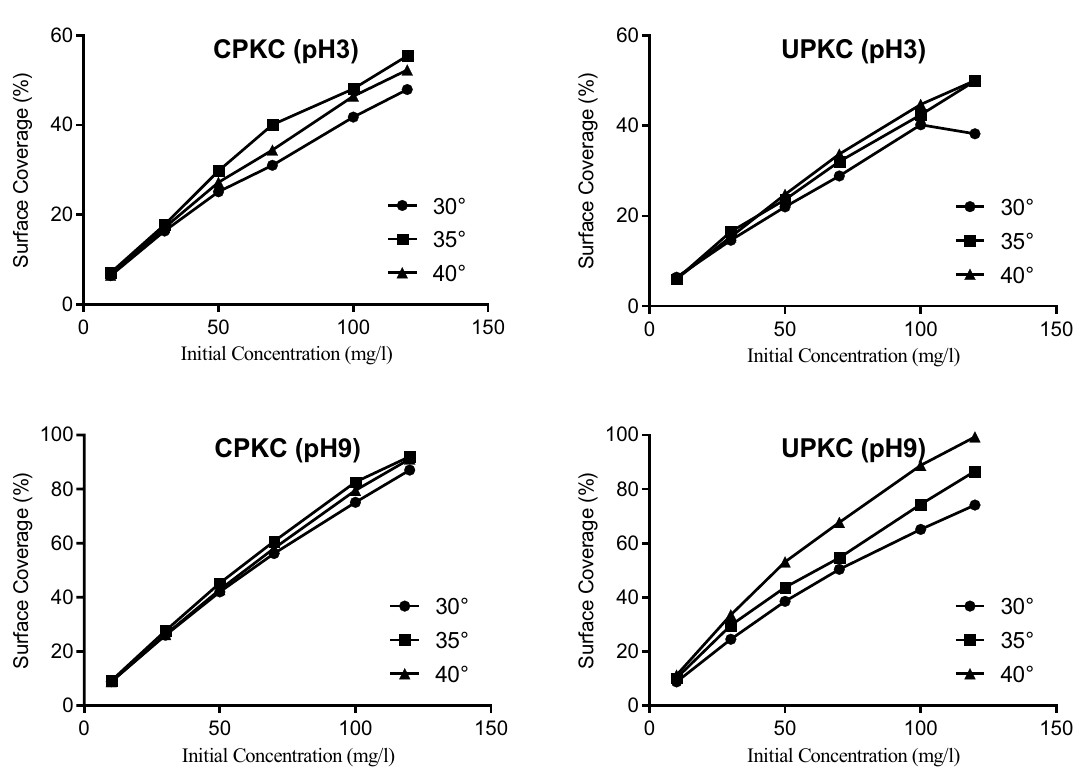
Figure 6. Plots of surface coverage of adsorbents for different temperatures and